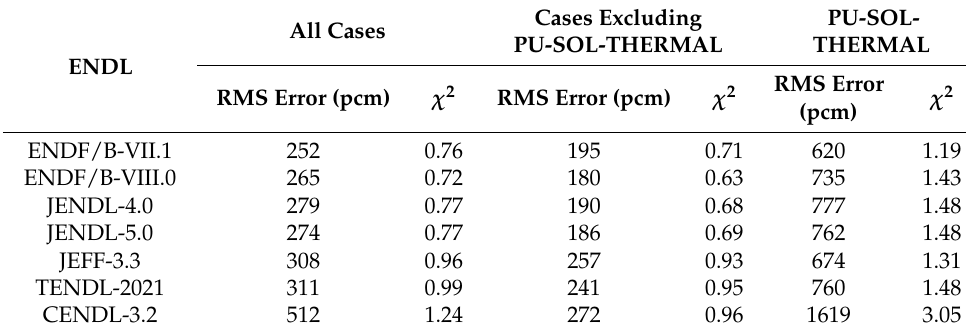
Figure 5. The difference between calculated and experimental k eff by ENDL for the ICSBEP thermal benchmarks. Table 6. RMS errors and chi square values of the 54 thermal benchmarks for different evaluated nuclear data libraries.